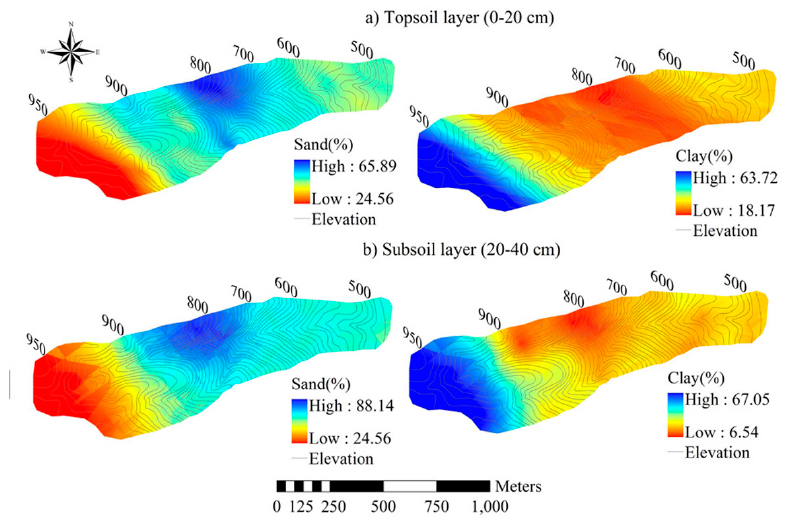
Figure 7. Spatial distributions of soil sand and clay content in the top- and subsoil layers in the Laozhai catchment.